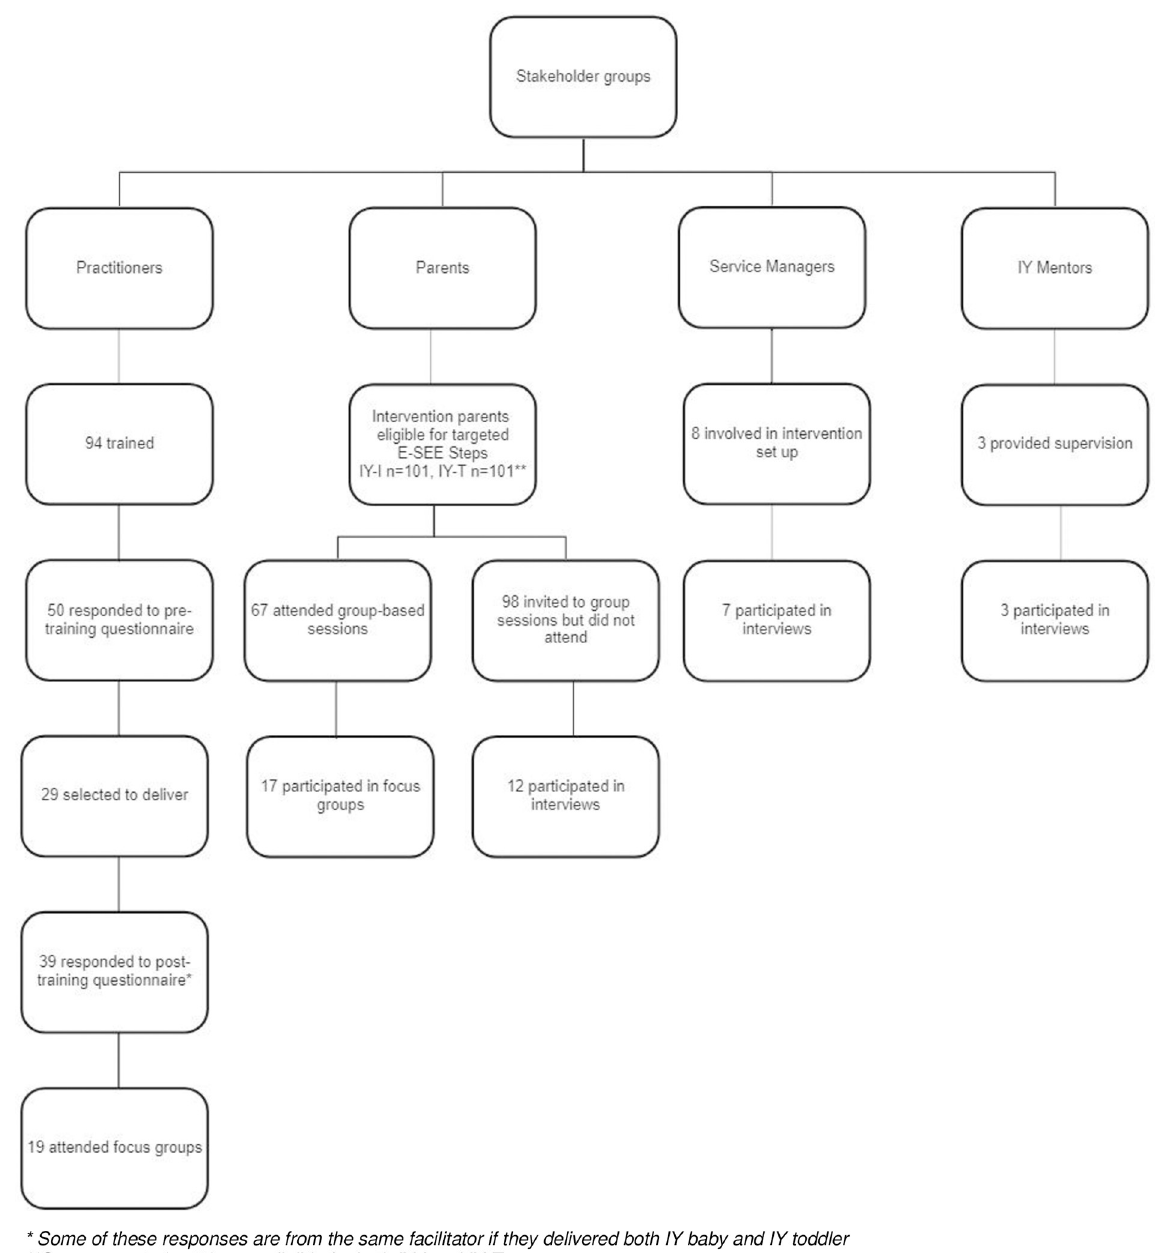
Fig 1. Flowchart of process evaluation